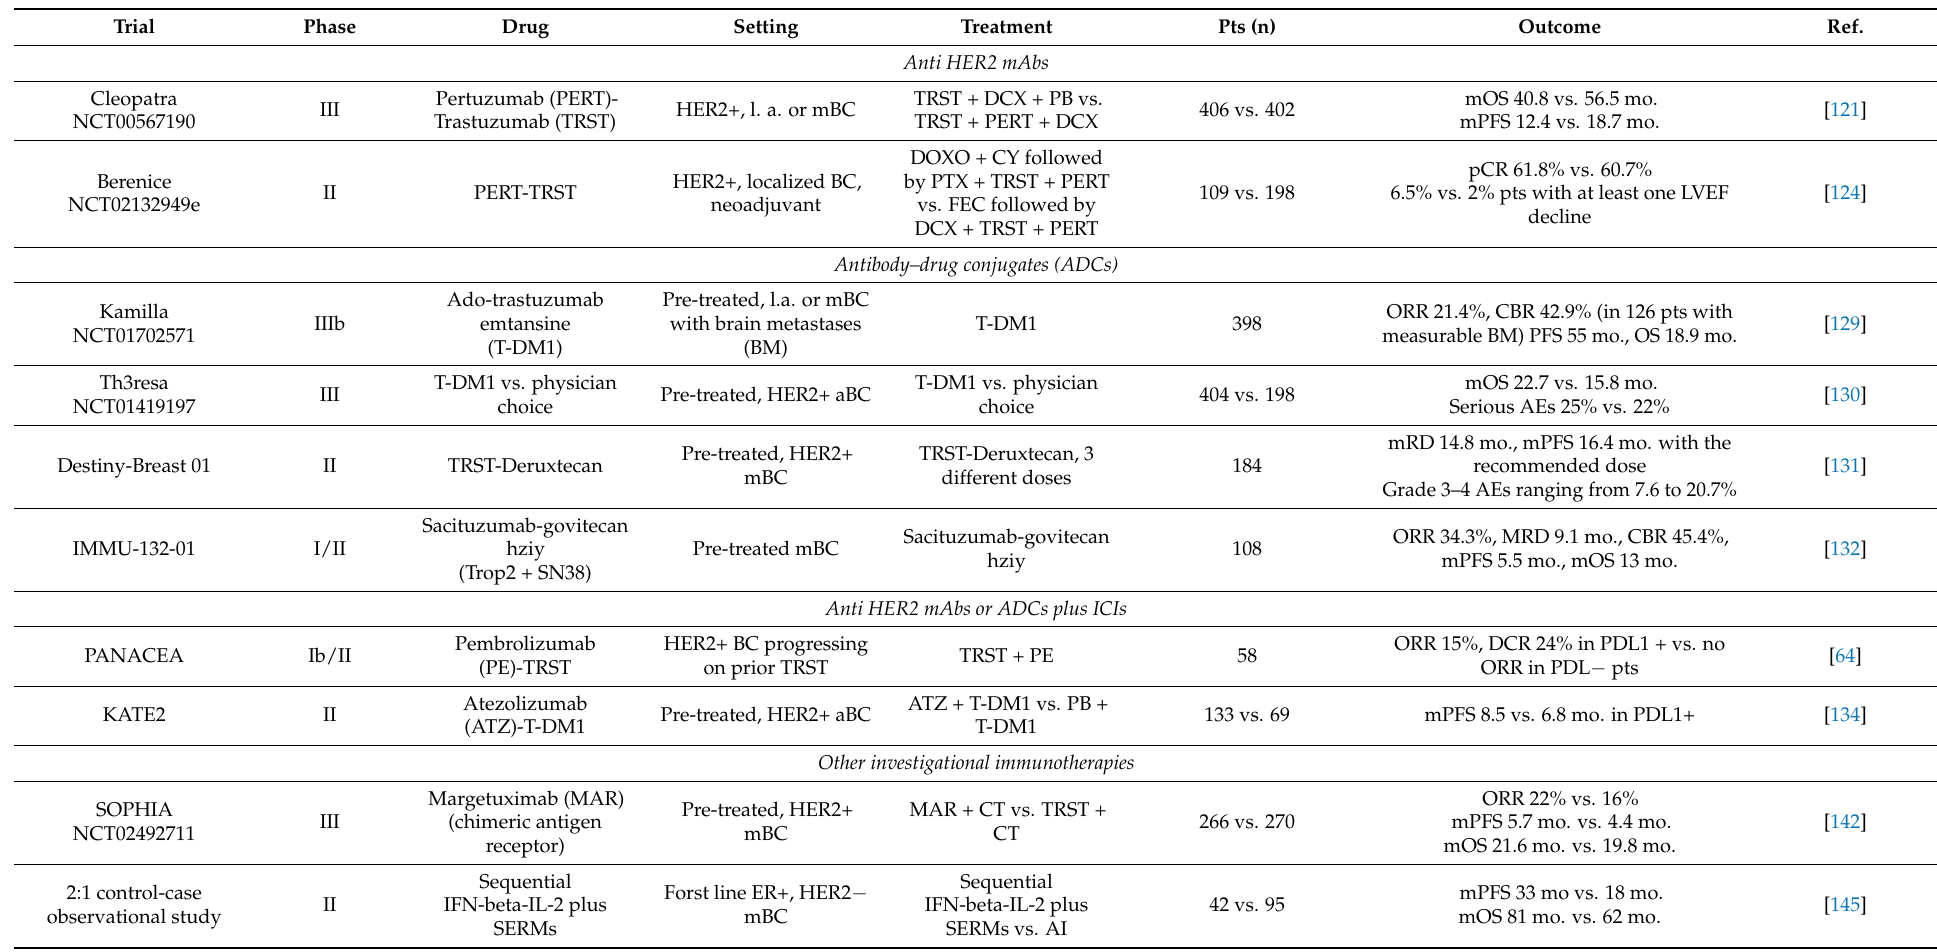
Table 3. Major clinical trials recently conducted with anti-HER2 monoclonal antibodies (mAbs), antibody–drug conjugates (ADCs), their combination ICIs, and other investigational